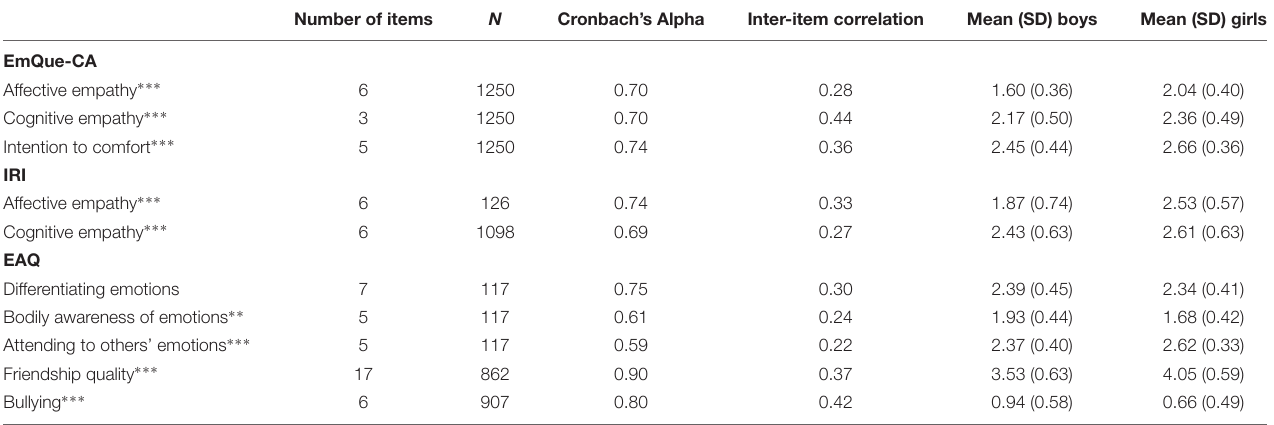
TABLE 3 | Construct consistencies of the three scales of the Empathy Questionnaire for children and adolescents